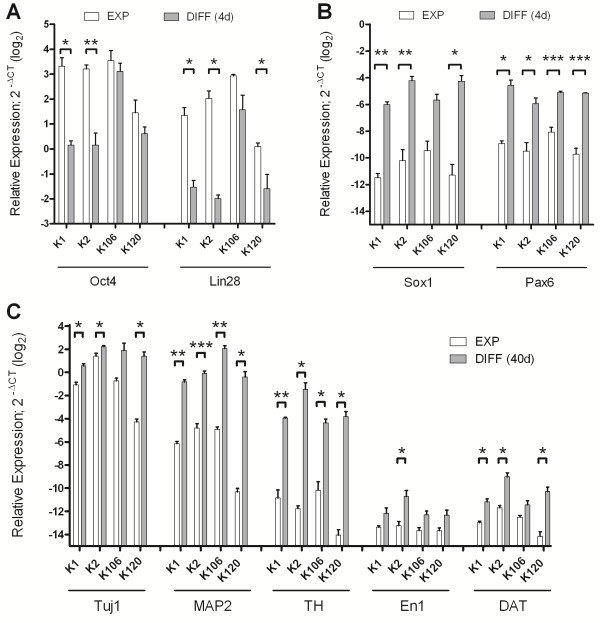
Quantitative real-time PCR of four hCBiPSC lines. Relative expression levels of pluripotency (A), neural progenitor (B) and neuronal and dopaminergic markers (C) in four hCBiPSC clones (K1, K2, K106, K120). (A) The expression of the pluripotency markers Oct4 and Lin28 is significantly decreased in most cell lines during expansion whereas the neural stem cell markers Sox1 and Pax6 (B) are markedly upregulated in all hCBiPSC clones after differentiation with DM/SB for four days. (C) After 40 days of differentiation in vitro the relative expression of the neuronal markers Tuj1 and MAP2 is significantly enhanced in almost all clones. Furthermore, the expression levels of tyrosine hydroxylase (TH) and the dopamine transporter (DAT) which are markers for dopaminergic neurons, as well as the mesencephalic marker engrailed 1 (En1) are significantly elevated in most cell lines. Results are reported as means ± SEM. P-values (*P <0.05, **P <0.01, ***P <0.001) were calculated using an unpaired t-test. Abbreviations: EXP, expanded cells; DIFF, differentiated cells. DM, dorsomorphin; hCBiPSC, human cord blood induced pluripotent stem cells; SEM, standard error of the mean.